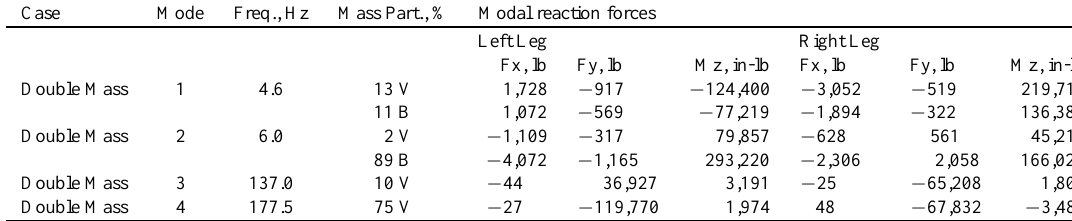
Table 7 Shock analysis results for double-mass rod cases; Asymmetric mass